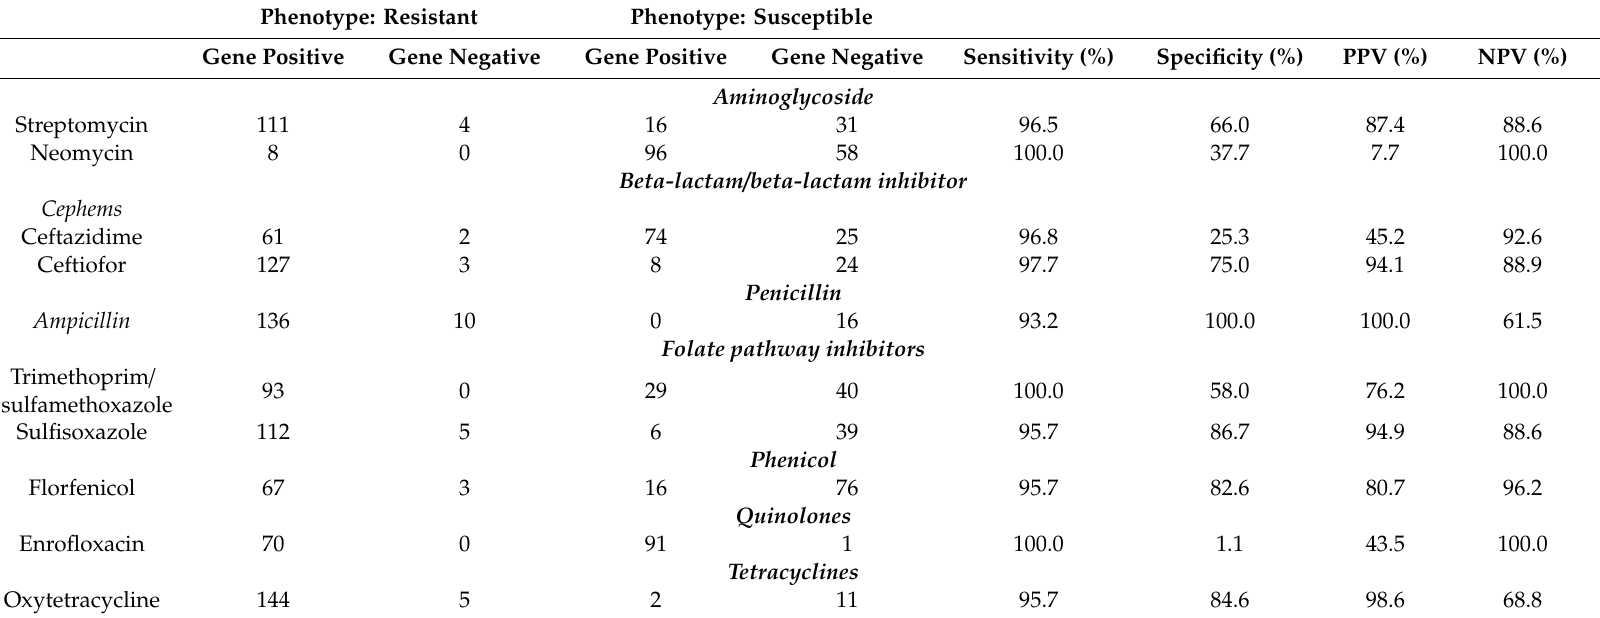
Table 1. Genotype and phenotype comparison of presumptive ESBL E. coli isolated from along a One Health